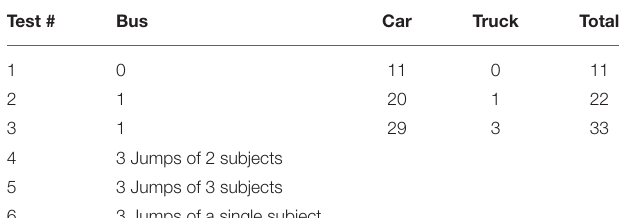
TABLE 1 | Vehicle count of the test data.